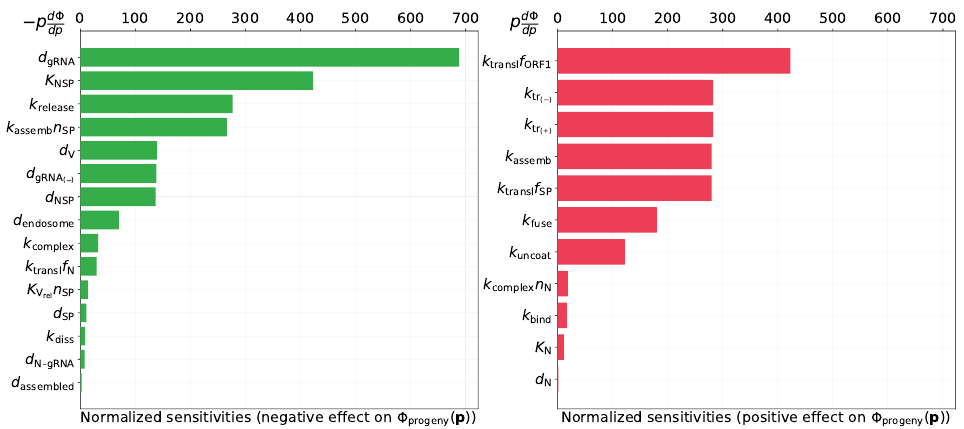
Figure 6. Local normalized sensitivity indices having negative ( left ) and positive ( right ) effect on the total number of released virions Φ progeny ( p ) .